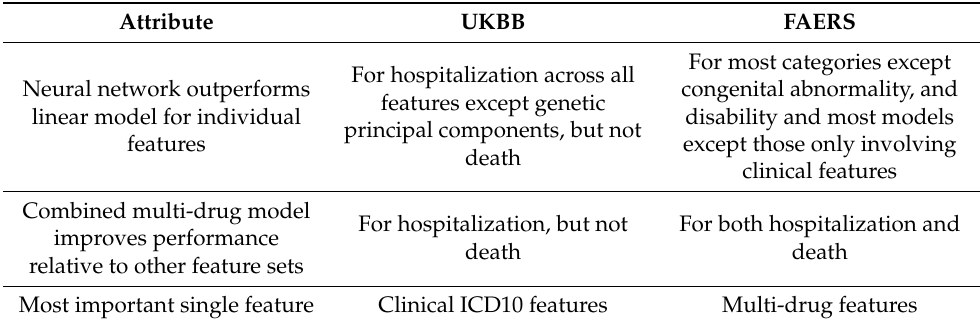
Table 3. Summary and support of key findings in each of the two datasets